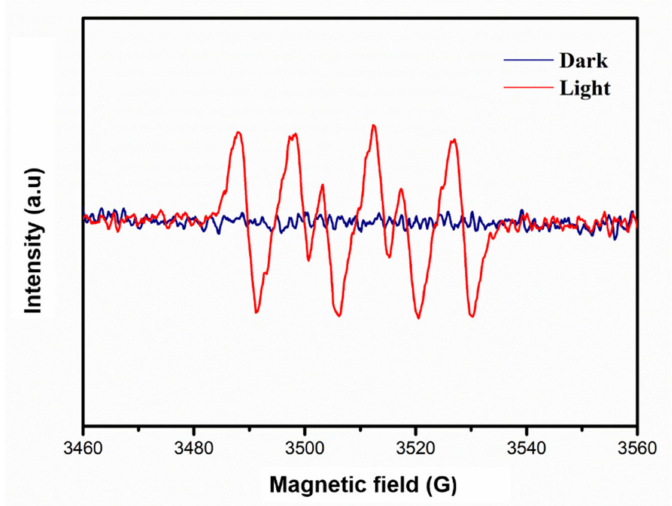
Figure 10. DMPO spin-trapping EPR spectra of • O 2 − in MeB solution under dark conditions and visible light